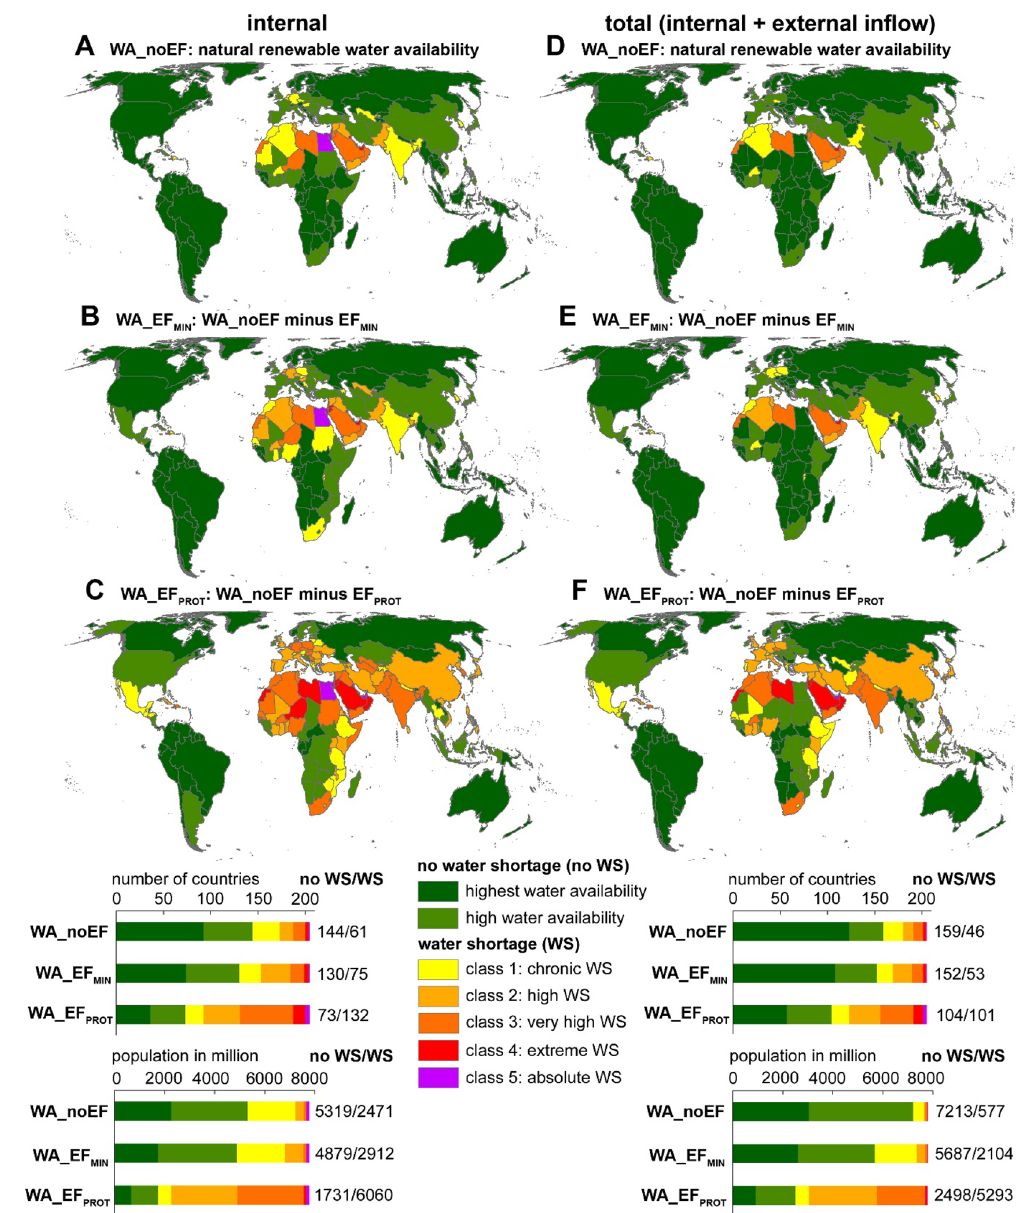
Figure 2. National internal (left column) and total (right column) renewable water shortage for WA_noEF ( A , D ), WA_EF MIN ( B , E ) and WA_EF PROT ( C , F ), year 2020. The bottom graph shows the number of countries and associated population under different levels of water shortage. Maps generated with ArcMap (Version 10.8, https:// www. esri.